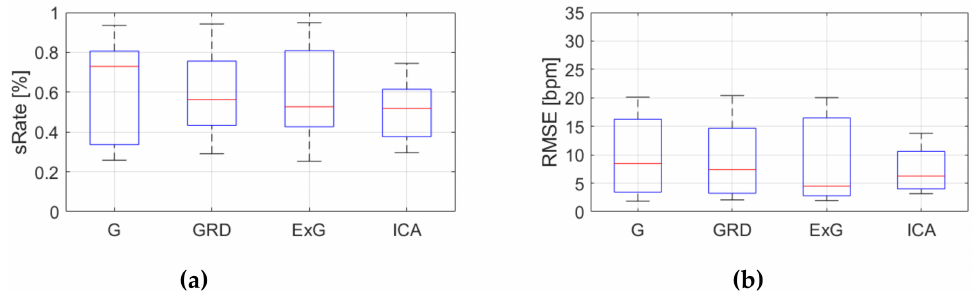
Figure 13. Comparison of signal extraction methods, algorithm No.2 (AR), part 1: ( a ) box plots for sRate ; ( b ) box plots for RMSE . Blue lines—IQR range, red line—median